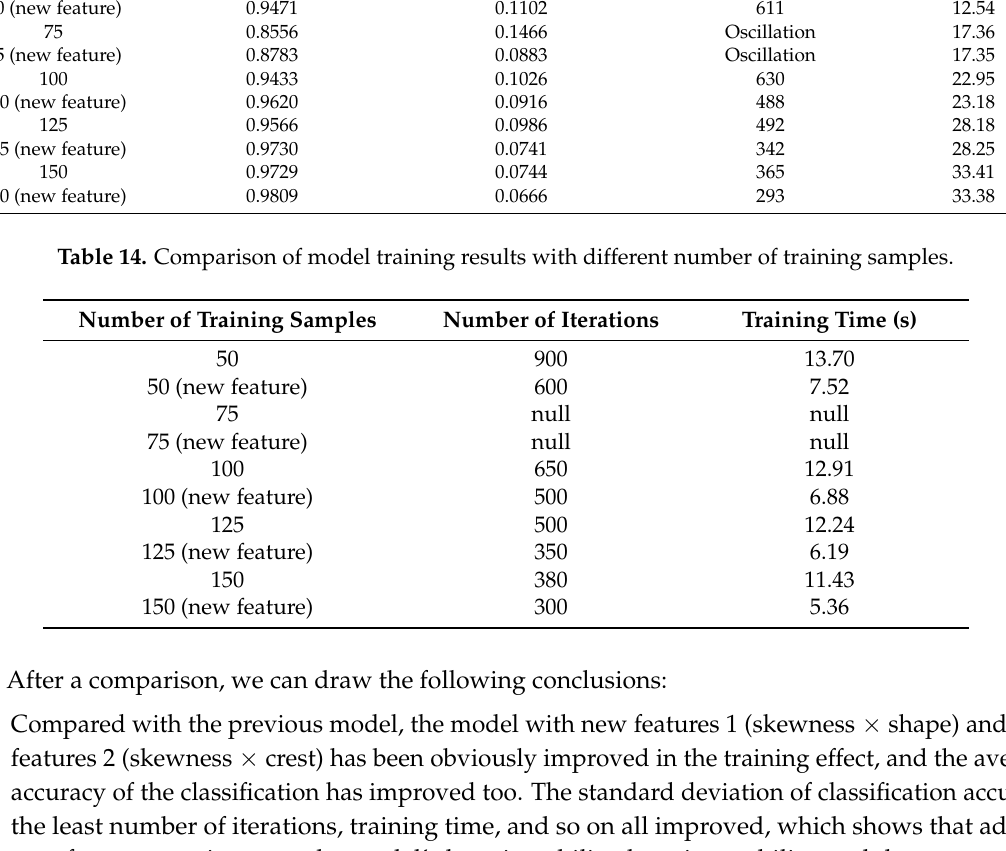
Figure 19. One hundred fifty training samples of the neural network.